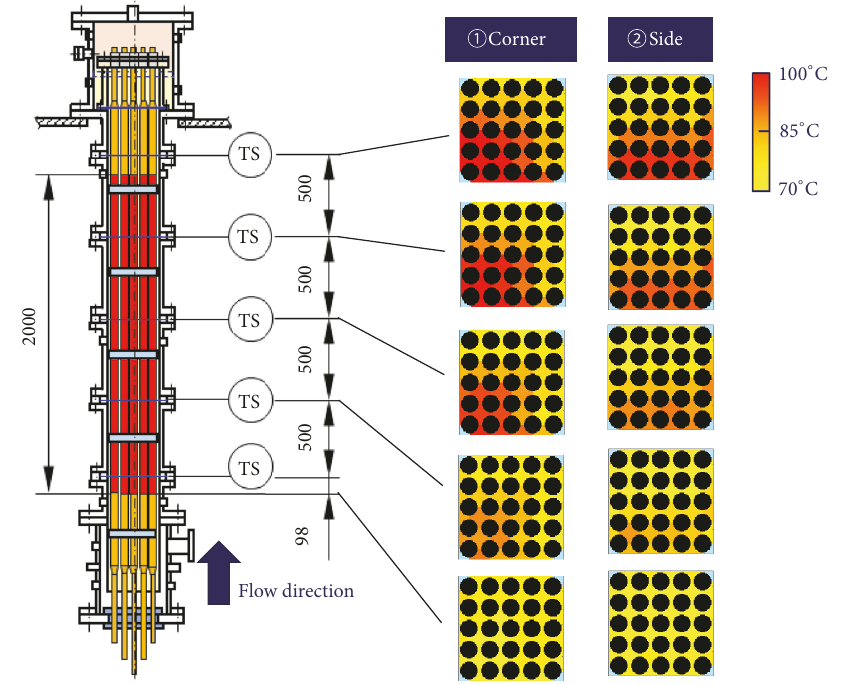
Figure 9: Visualized images of the sensor measurement